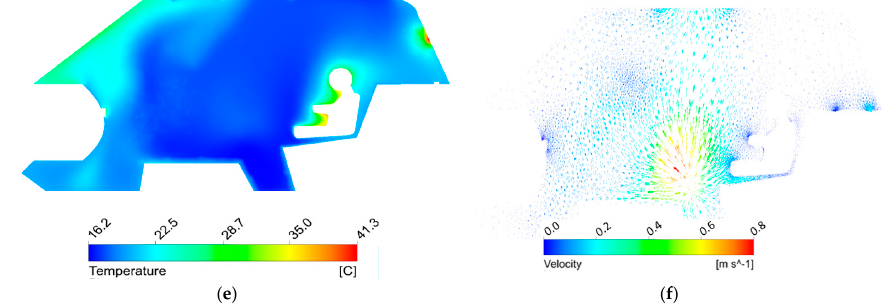
Figure 5. Predicted temperature and velocity fields for all of the considered variants. Case 1 ( a ) Temperature profile and ( b ) Velocity contours. Case 2 ( c ) Temperature profile and ( d ) Velocity contours. Case 3 ( e ) Temperature profile and ( f ) Velocity contours.